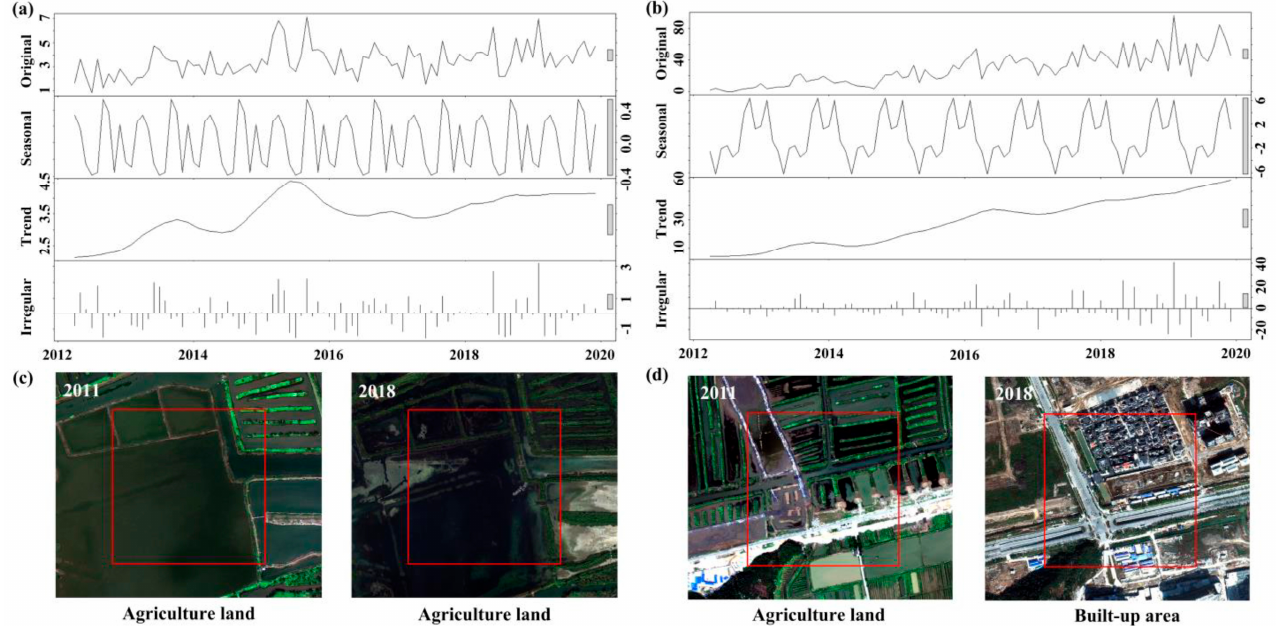
Figure 5. STL time series decomposition with stable land coverage ( a ), changed land coverage ( b ), WorldView images ( c ), and ( d ) for the corresponding regions. The red squares (500 m × 500 m) in ( c , d ) represent the corresponding location of ( a , b ), respectively.